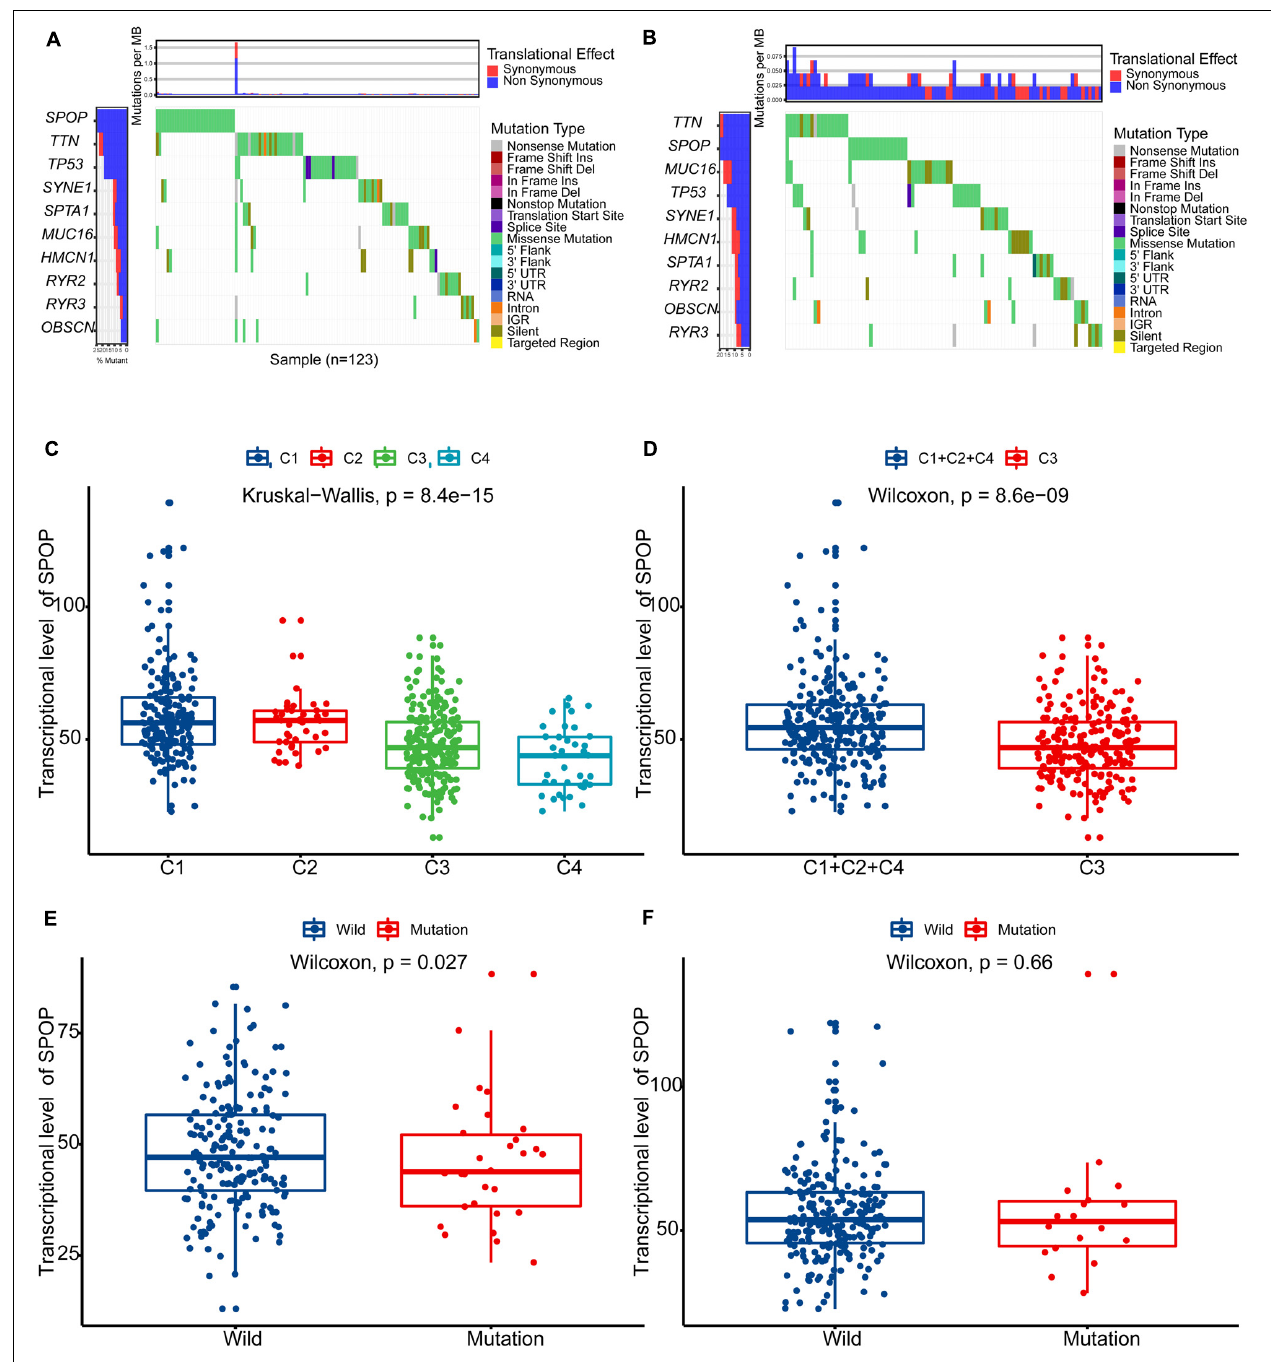
FIGURE 3 | Difference of somatic variations between high-risk (C3) and low-risk (C1 + 2 + 4) groups. (A) The map of waterfall for high-risk (C3) group. (B) The map of waterfall for low-risk (C1 + 2 + 4) group. (C) The differences in the transcription levels of SPOP in different subtypes (C1, C2, C3, and C4). (D) The differences in the transcription levels of SPOP between high-risk (C3) and low-risk (C1 + 2 + 4) groups. (E) In the high-risk (C3) group, SPOP transcription level of patients with SPOP mutation was significantly lower than that of patients with wild-type SPOP . (F) In the low-risk (C1 + 2 + 4) group, there was no significant difference in SPOP transcription between the mutant and the wild-type patients. PCa, prostate cancer; SPOP , Speckle-type POZ Protein.